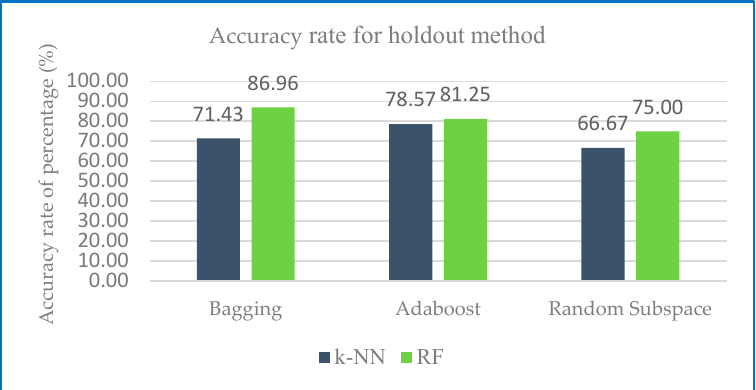
Figure 10. Accuracy rate of Dataset 1 with 10- fold cross validation method.